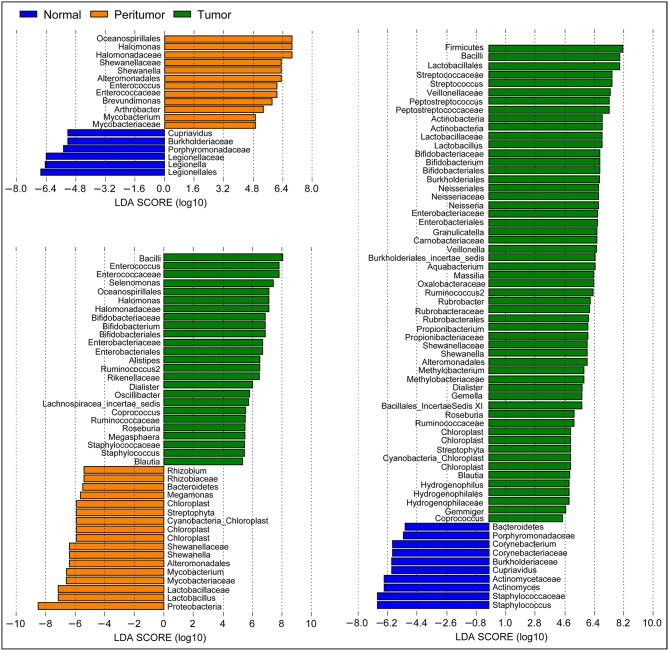
Different bacterial taxa among the three stomach microhabitats. LEfSe identifies the taxa with the greatest differences in abundance among the three stomach microhabitats. Only the taxa meeting a significant LDA threshold value of >2 are shown.